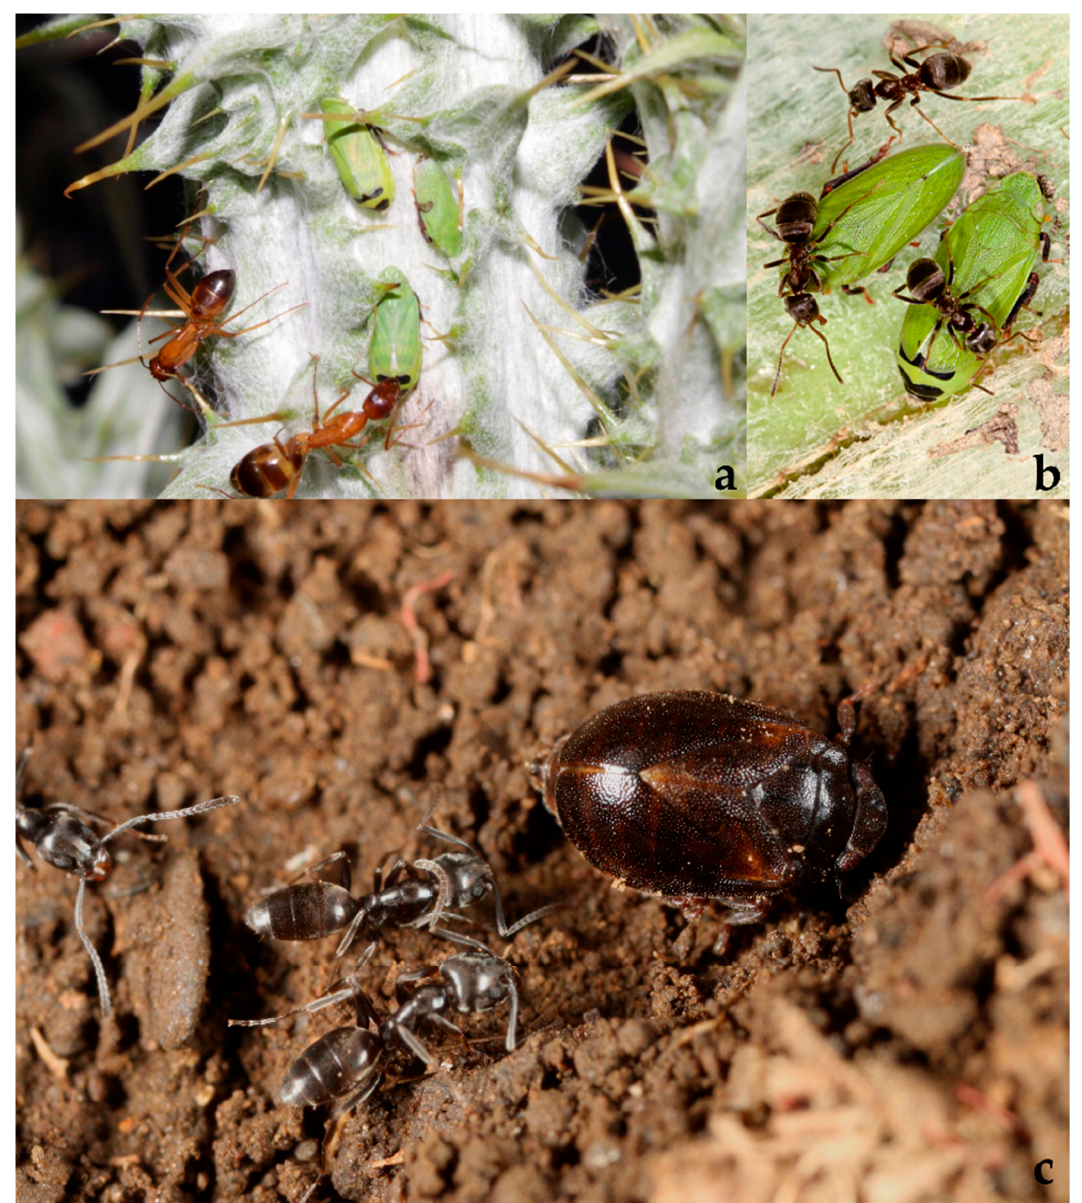
Figure 32. Tettigometridae: ( a ) Tettigometra ( Tettigometra ) sulphurea Mulsant and Rey, 1855 tended by Formicidae: Formicinae: Camponotus sp., Greece: Lesbos, Voreio Aigaio, 39°11 ′ 21.9 ″ N 26°27 ′ 47.8 ″ E, 12.02.2021, adults on Onopordon acanthium L. (Asteraceae), obs. S. Zafeiriou; ( b ) T. ( Tettigometra ) sulphurea tended by Formicidae: Formicinae: Lasius paralienus Seifert, 1992, Serbia: Frushka gora, Neradin vill., nymphs and adults on Onopordon acanthium (Asteraceae), obs. D. Savic; ( c ) T. ( Eurychila ) bifoveolata Signoret, 1866 tended by Formicidae: Dolichoderinae: Tapinoma sp., France: Pyré- nées Orientales, Banyuls, 02.2022, adults in ant nest, obs. H. Bouyon.